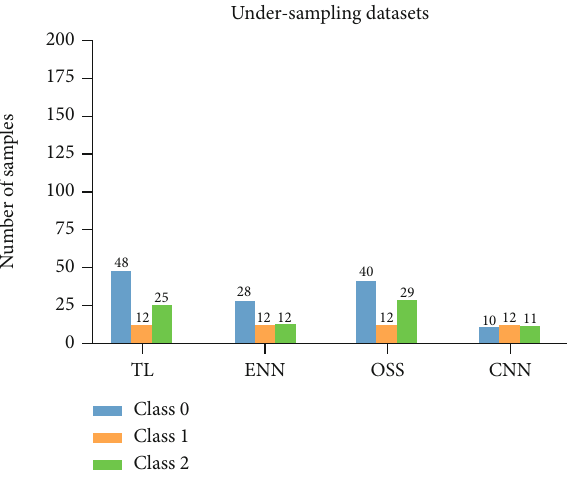
Figure 5: Number of samples per class in the original